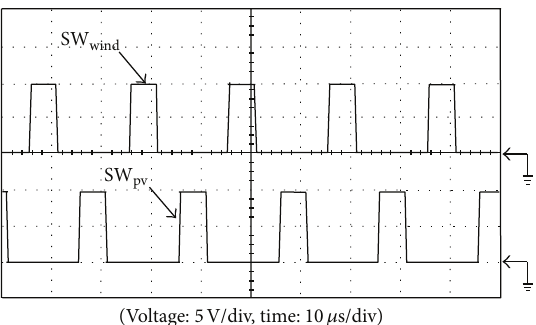
Figure 20: Simulated control signals while hybrid wind-PV power is 700